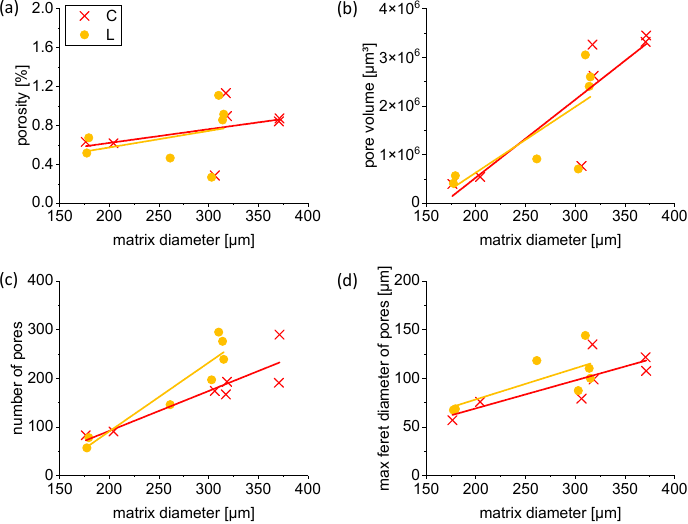
Figure 6. Porosity, pore volume, number of pores and maximum Feret diameter depending on matrix diameter of struts for scanning types L and C. Graph ( a ) shows an overall small porosity, slightly increasing with rising matrix diameter. Pore volume ( b ), number of pores ( c ) and maximum Feret diameter of pores ( d ) increase with rising matrix diameter. The lines are intended to guide the eye of the reader and do not represent linear fits.